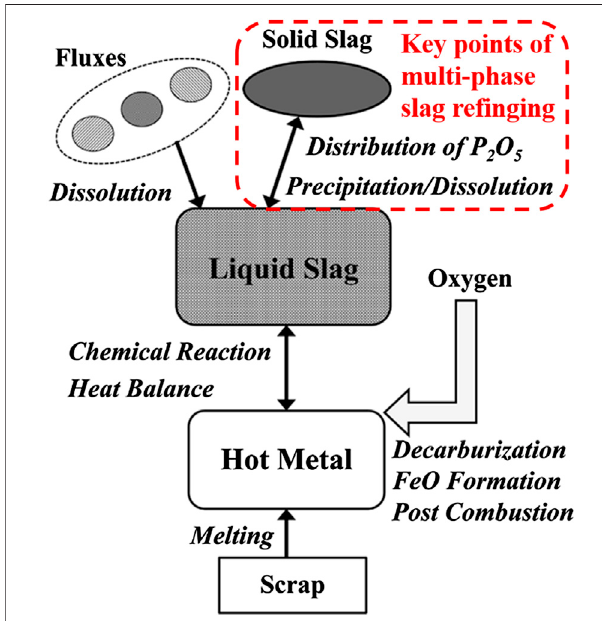
FIGURE 7 | |Phases and reactions considered in the MPSR model (Kitamura et al., 2014). [Figure 2 of (Kitamura et al., 2014), Copyright The Iron and Steel Institute of